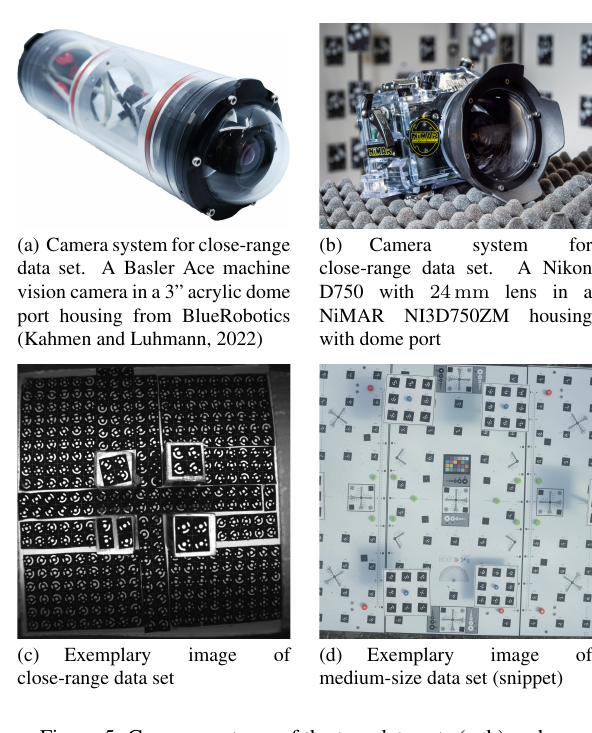
Figure 5. Camera systems of the two data sets (a, b) and an exemplary image from the bundles (c, d). Note: Due to poor focus, the elevated points visible in (c) for the close-range data set were removed, resulting in the described 2D